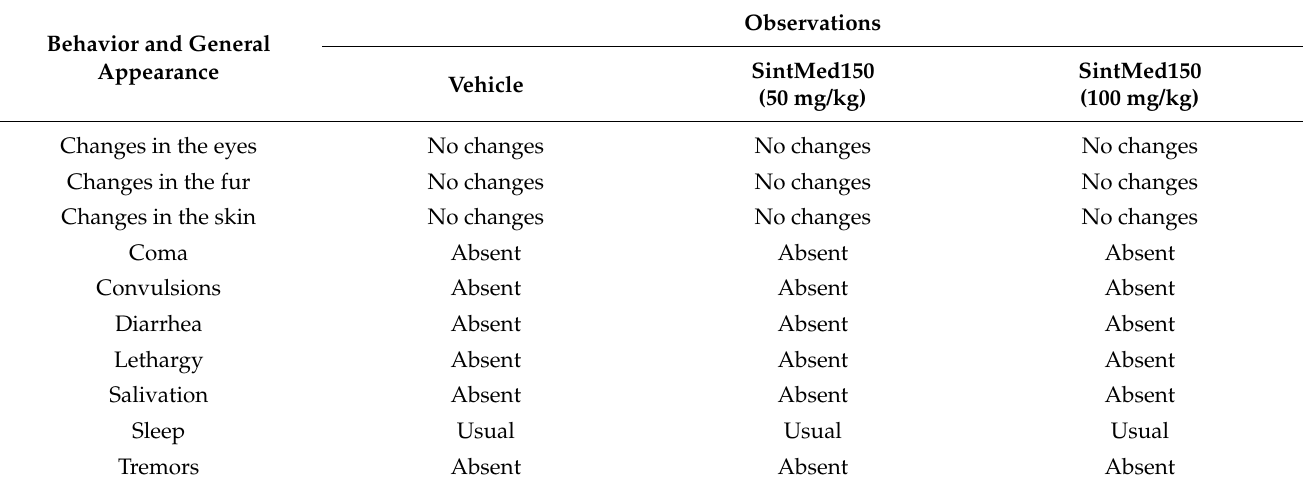
Table 2. Effect of SintMed150 on behavioral and general appearance of male BALB/c mice.